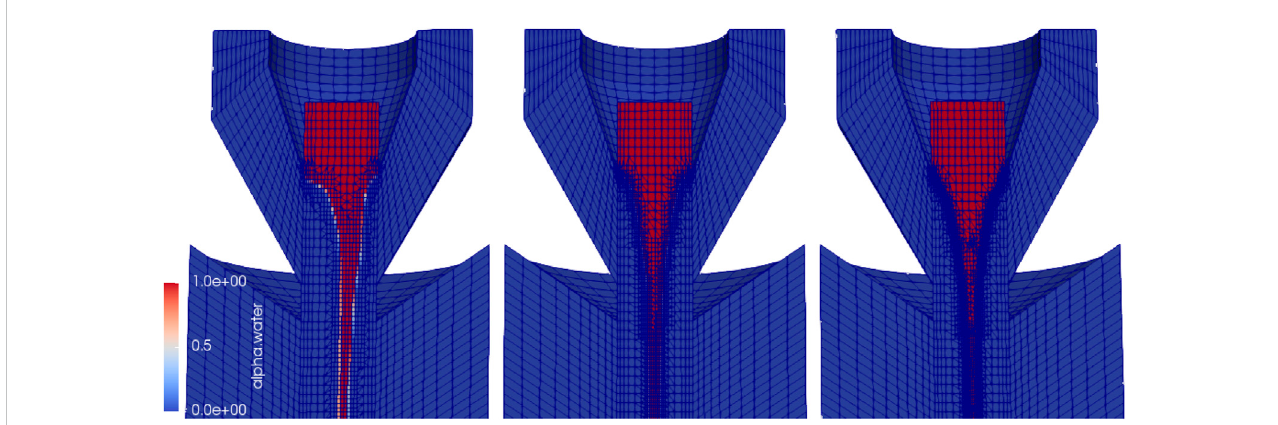
FIGURE 8 Grid resolution independence study for the numerical simulation test case of the bell-shaped nozzle. The left picture corresponds to one-level AMR without global mesh re fi nement (coarsest mesh resolution in the vicinity of the liquid – gas interface), the middle picture corresponds to two-level AMR (medium mesh resolution in the vicinity of the liquid – gas interface), and the right picture corresponds to three-level AMR ( fi ne mesh resolution in the vicinity of the liquid – gas interface).